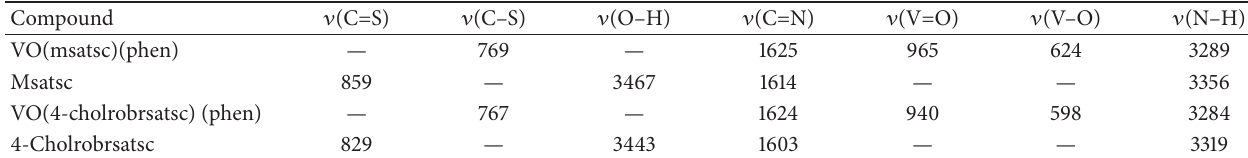
Table 1: Selected IR data for complexes and their corresponding ligands 𝜈 (cm − 1